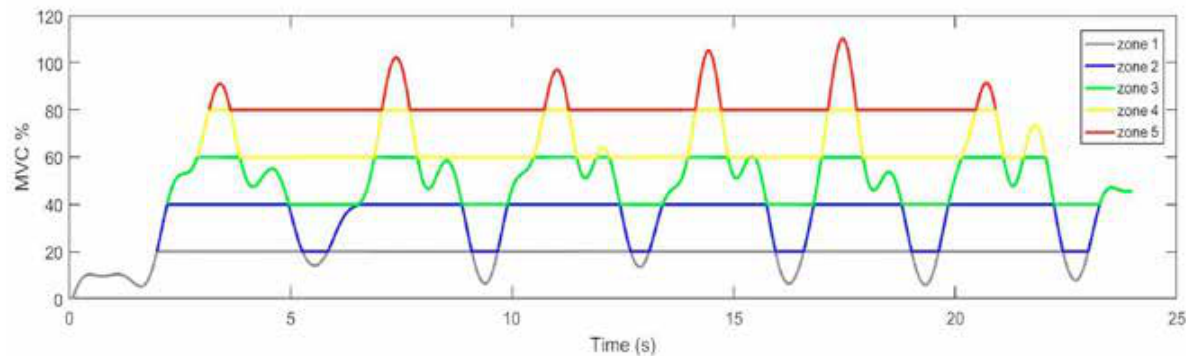
Figure 5. Sample data for the analysis process of EMG data during the PLC and NC exercises: a. EMG data that was applied a band pass filter within the range of 10-500 Hz: b. MVC% values that were normalized using the EMG values during the maximal isometric contraction: c. Cumulative integrated EMG data: d. Five different intensity zones that were created based on the MVC%